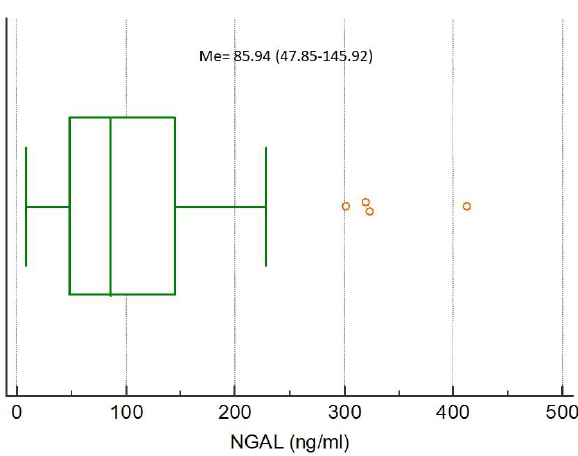
Figure 2. Distribution of the neutrophil gelatinase-associated lipocalin (NGAL) concentrations in the study population. Circles indicate outliers and far out values illustrated as single data points.